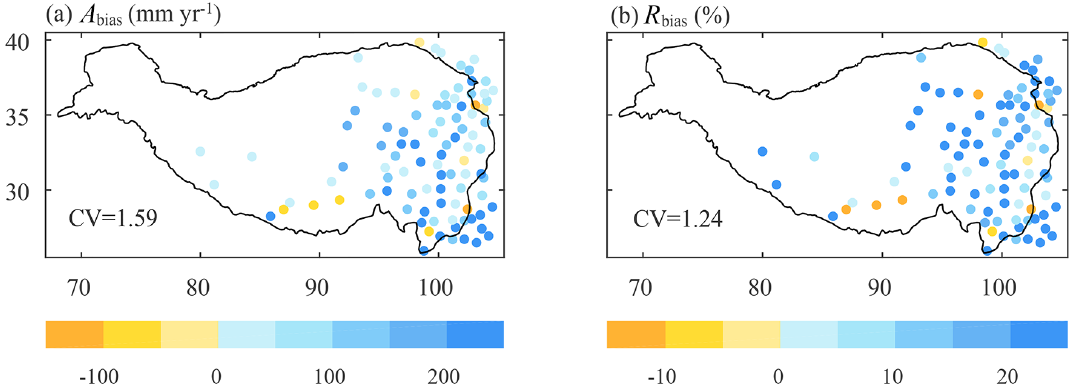
Figure 7. Spatial distribution of (a) absolute bias ( A bias ) and (b) relative bias ( R bias ) for annual precipitation from ERA5_CNN during 1980–2018 at stations of the China Meteorological